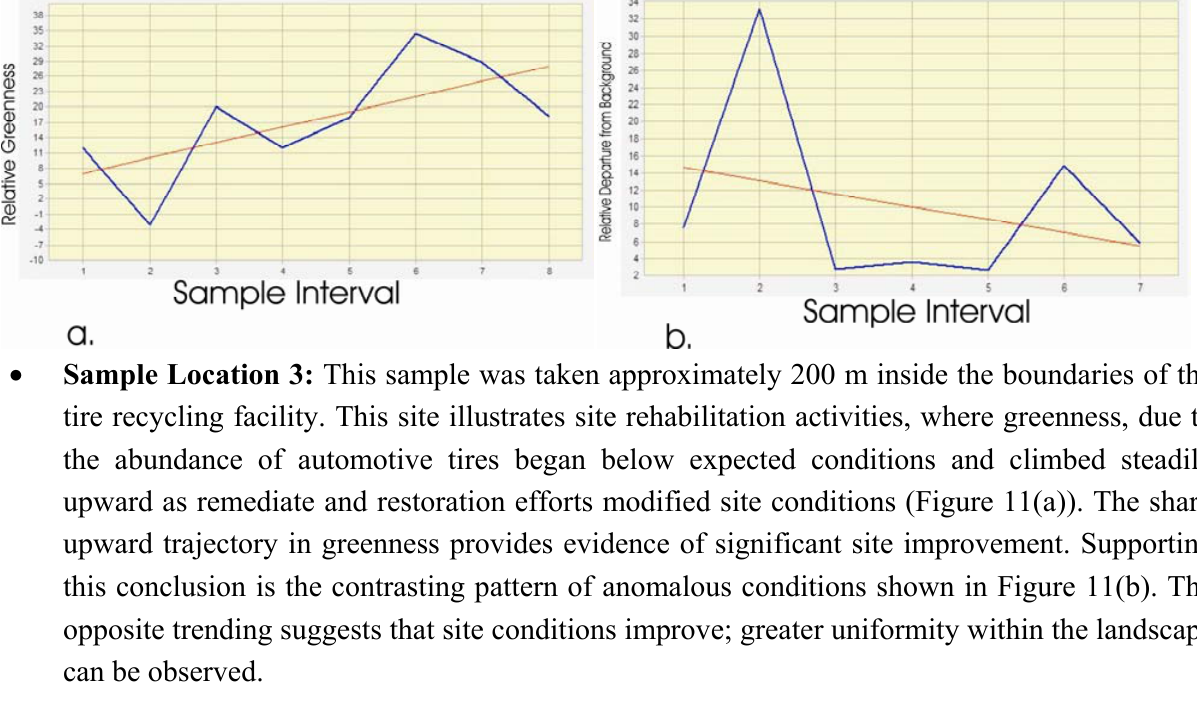
Figure 11. Greenness (a) and Anomaly (b) profiles for Sample #3 covering anniversary dates from 1998 through 2009 with x-axis not to